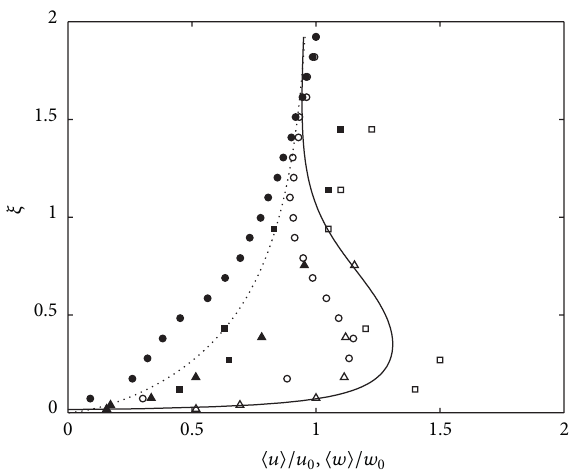
Figure 4: Typical r.m.s velocity profiles at near tank base where data shown is generated from flow 𝑅𝑒 𝑙 = 570 ( ∘ ), plotted together with data extracted from Brumley ( 󳵻 ) and Hannoun ( ◻ ). The predicted lines derived by Hunt and Graham [6] are also shown as solid line and dashed line for 𝑢 and 𝑤 velocity components, respectively. Open bulletsandfilledbulletsrepresentthedimensionlessr.m.shorizontal and vertical components,